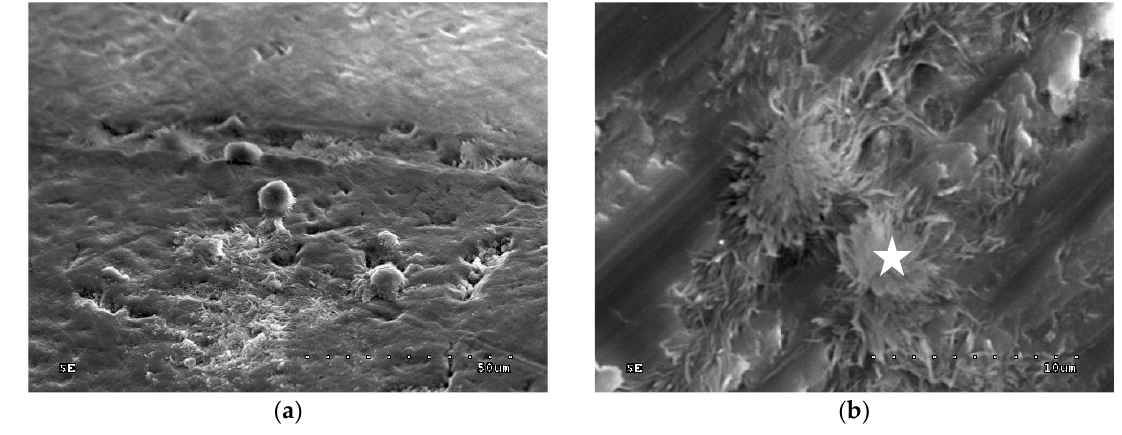
Figure 2. SEM image of dentine after application of 2.0% CHG for 30 s and drained—group 4: ( a ) 1000×; ( b ) 5000×. Star indicates the location, where the chemical analysis was performed.